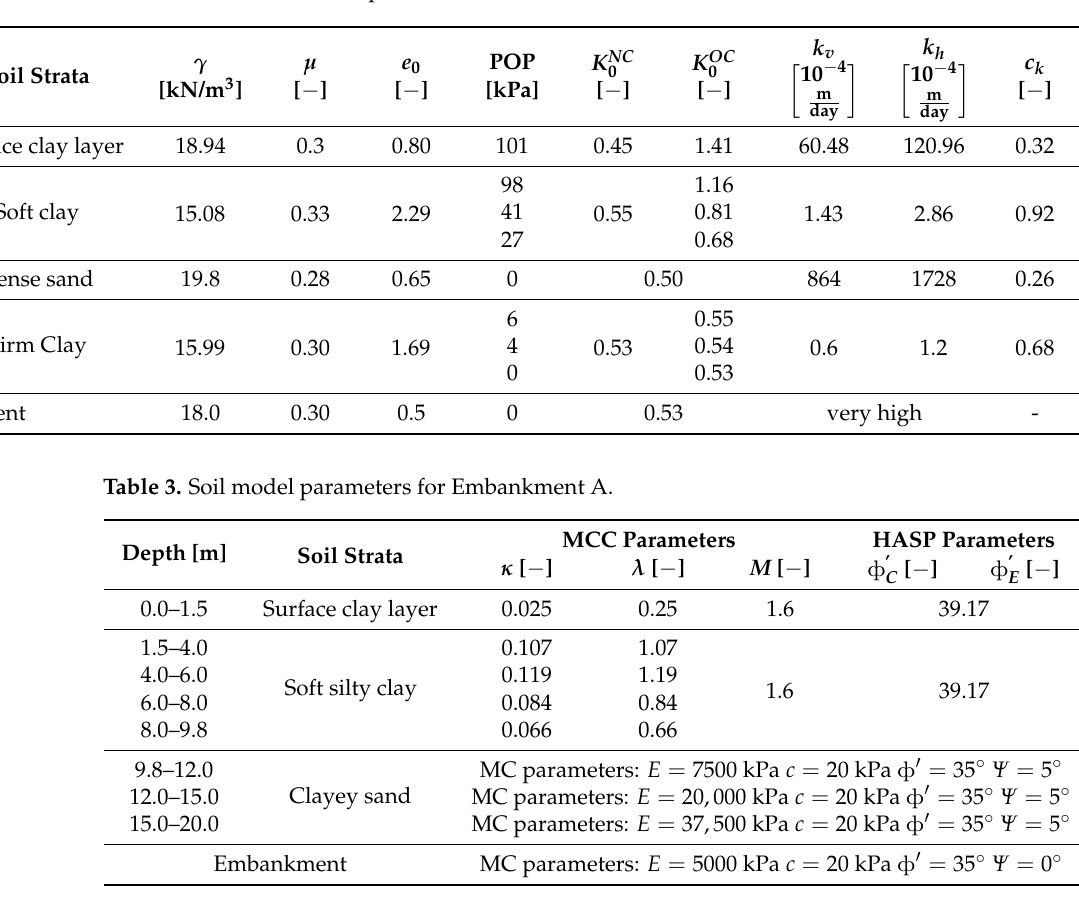
Table 2. Numerical model parameters for Embankment B.